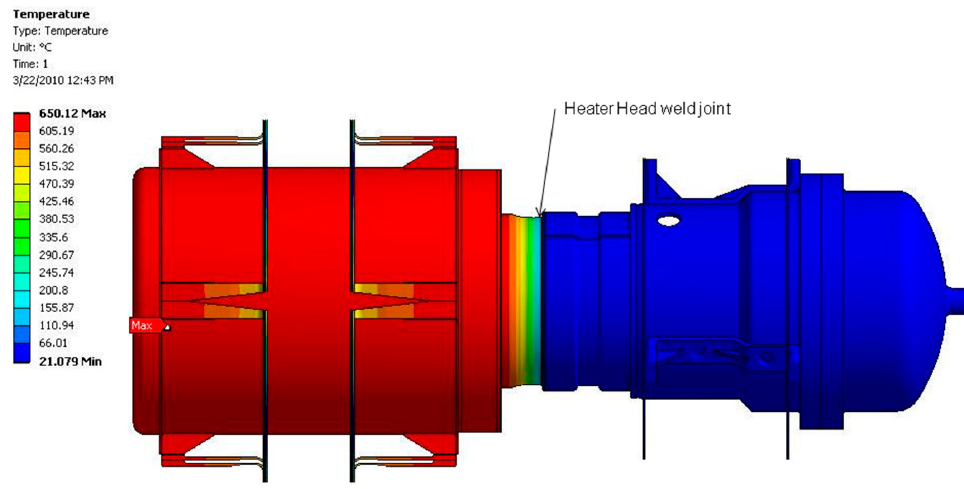
Figure 6. Temperature Field in Engine/TES System.